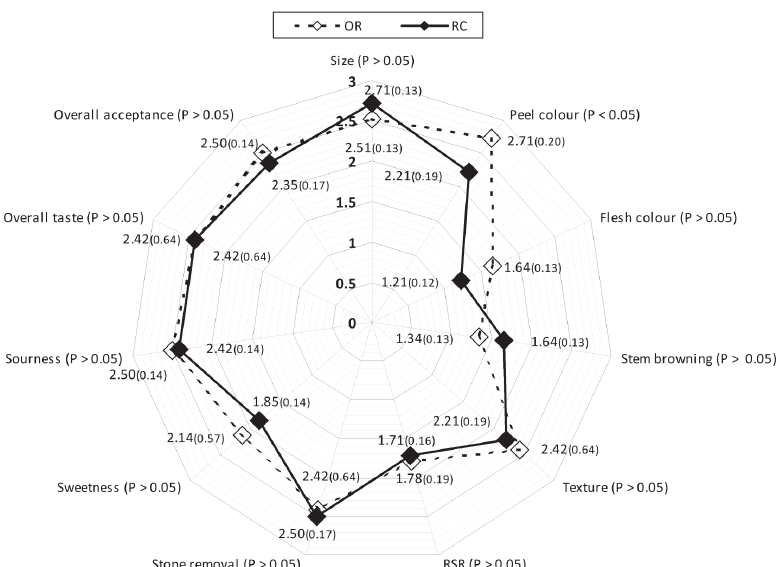
Fig. 4: Quantitative descriptive profile presented in a spider-web chart for sensory evaluation of ‘Noire de Meched’ cherries by 14 panelists at 20 o C after 14 d storage at 1 o C. OR, Orchard Uncovered; RC, Rain Covered Orchard. The evaluated attributes were: size, peel colour, flesh colour, stem browning, texture (firmness), resistance to stem removal (RSR), easiness of stone removal, sweetness, sourness, overall taste and overall acceptance. The num- The num - bers indicate the intensity of each attribute (1: low intensity; 2: medium intensity; 3: high intensity). The difference between means for each attribute was carried out by two-sample comparisons and the significance ( P ) is denoted within the parentheses. Each number in parenthesis next to each mean corresponds to SE. a redder or darker red colour (Fig. 4) in agreement with the objec - tive measurement. The difference in peel colour was the only sig - nificant attribute among the sensory ones observed. Consumers in Greece prefer dark red cherries with a sweet taste. The scores for flesh colour and sweetness were relatively low and of sourness